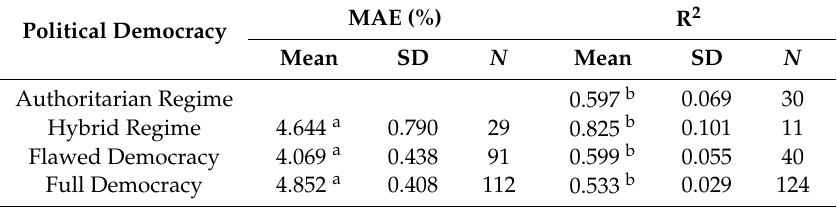
Table 5. Covariate-adjusted means predictive power across levels of political democracy. Political